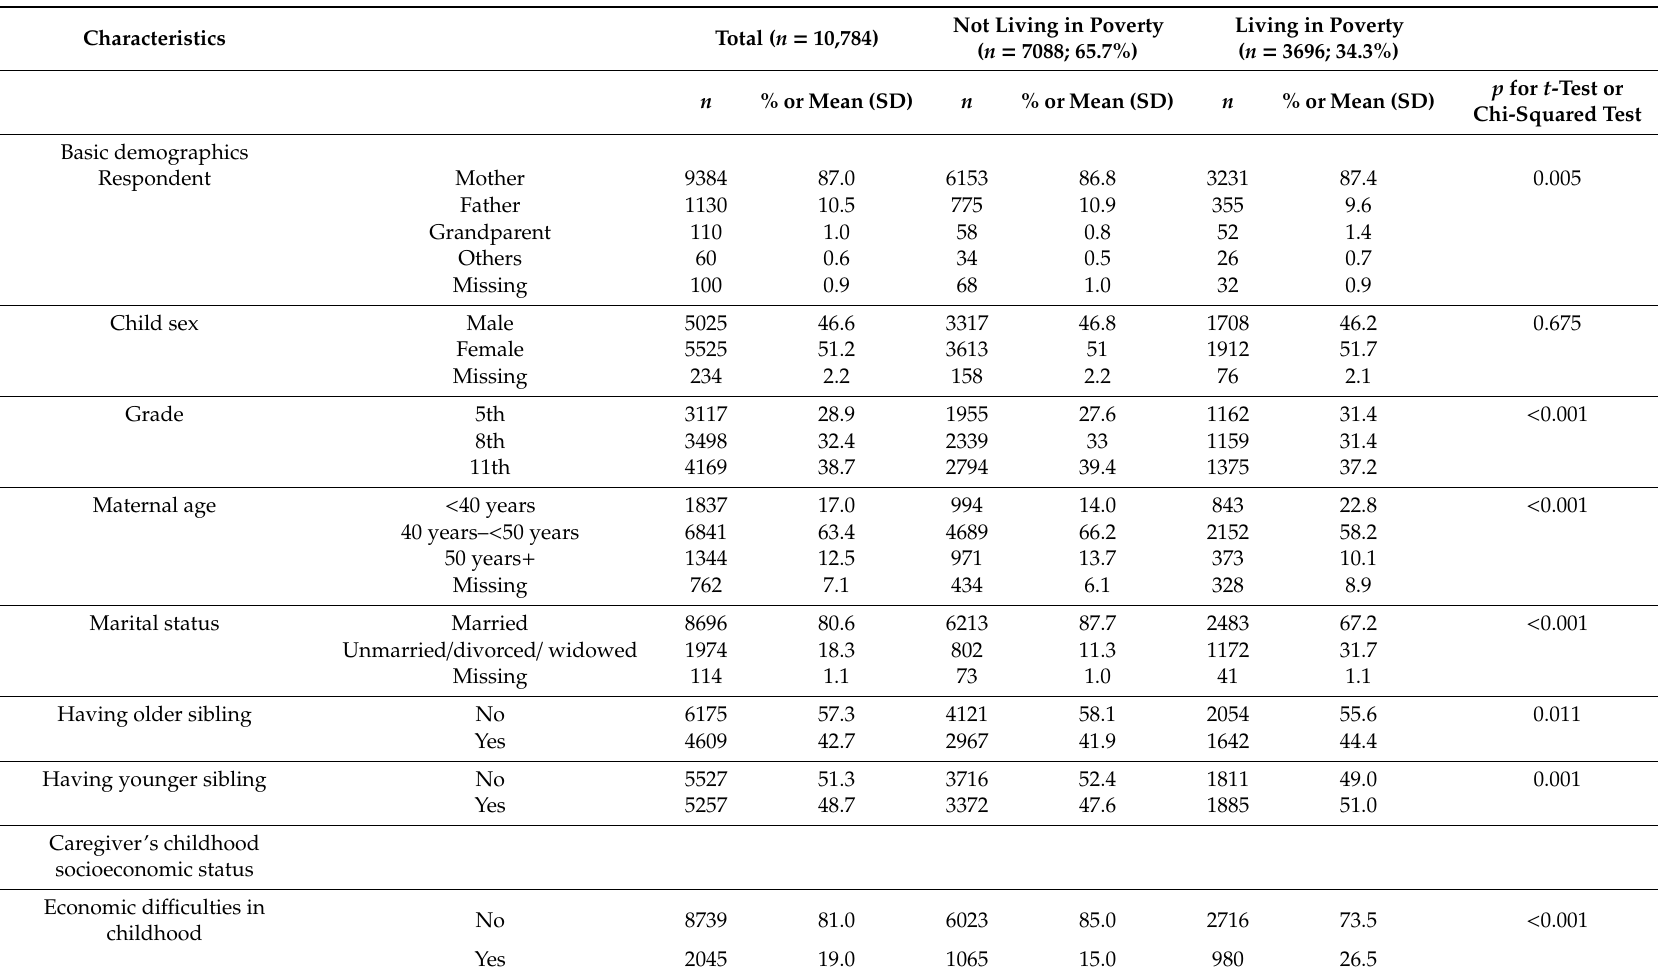
Table 1. Descriptive characteristics of the participants in this study ( n =